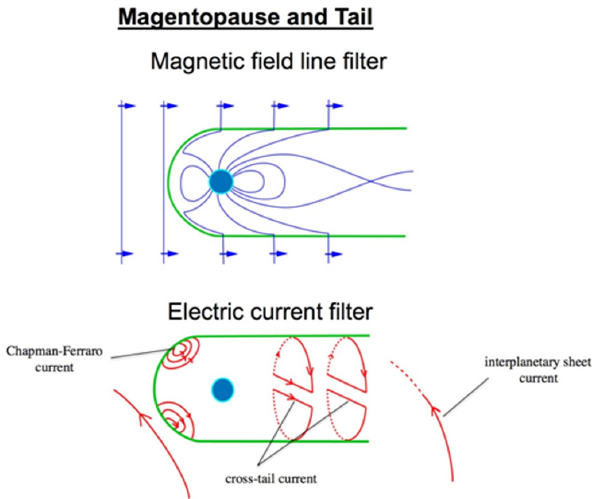
Fig. 8. The two views (magnetic field lines or electric currents) of the magnetopause and tail. The interplanetary current sheet will be discussed in Sect. 7.